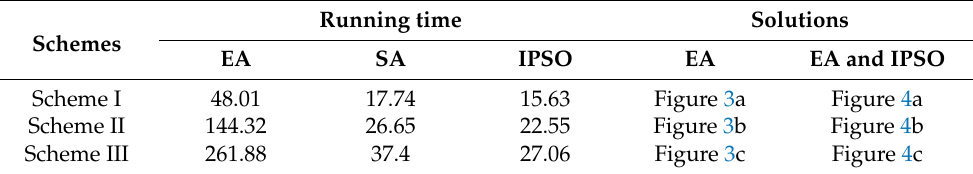
Table 3. Comparison of optimization results of different